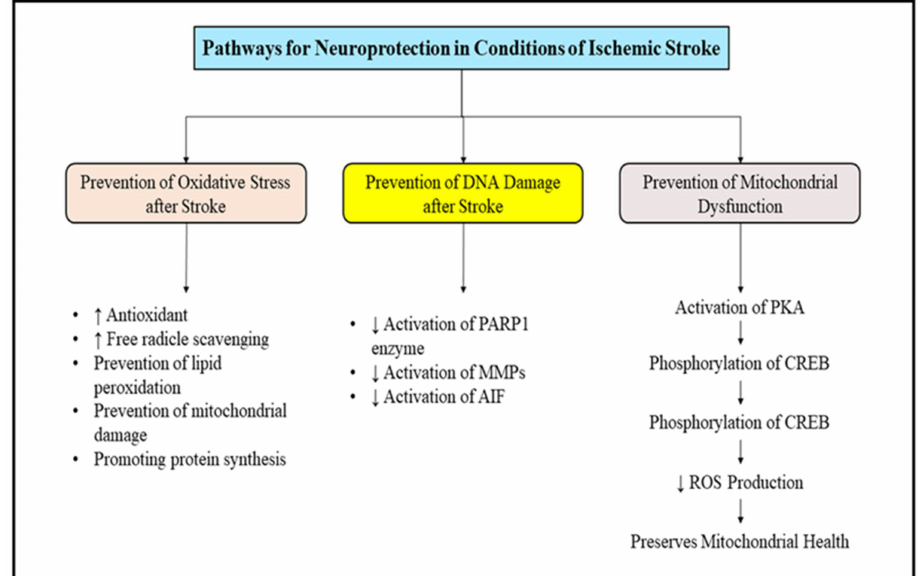
Figure 5. Targeted pathways for inducing neuroprotective effects after ischemic stroke. ROS: Reactive oxygen species; DNA: deoxyribonucleic acids; PARP1: poly ADP-ribose polymerase-1; MMP: Matrix metalloproteinase; AIF: apoptosis inducing factor: PKA: protein kinase A; CREB: cAMP response element-binding